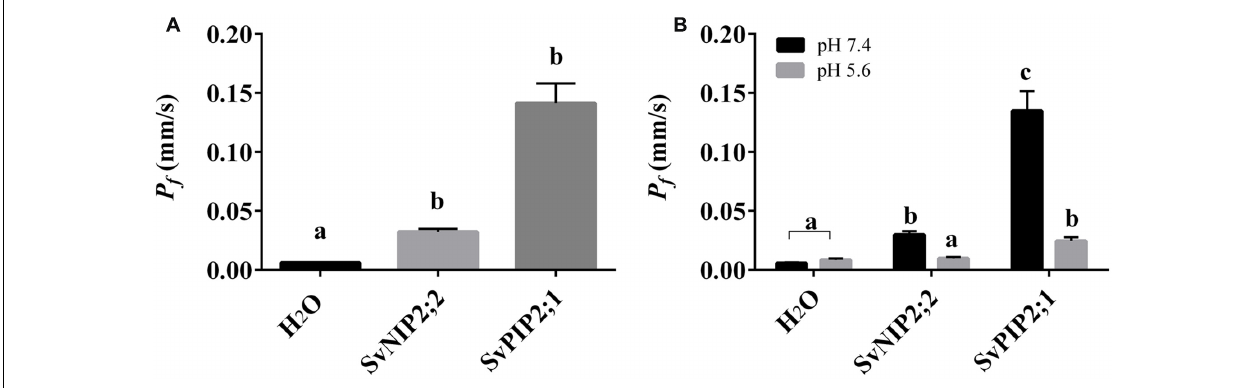
FIGURE 5 | Osmotic permeability ( P f ) of Xenopus laevis oocytes injected with SvNIP2;2 and SvPIP2;1 cRNA. (A) Osmotic permeability ( P f ) of water (H 2 O) injected and SvNIP2;2 and SvPIP2;1 cRNA (46 ng) injected oocytes. Oocytes were transferred into a hypo-osmotic solution, pH 7.4, and P f was calculated by video monitoring of the rate of oocyte swelling. (B) Effect of lowering oocyte cytosolic pH on osmotic permeability ( P f ) of H 2 O and SvNIP2;2 and SvPIP2;1 cRNA injected oocytes by bathing in hypo-osmotic solution supplemented with 50 mM Na-acetate, pH 5.6, n = 12–14; a = non-significant; b = p < 0.05; c = p <